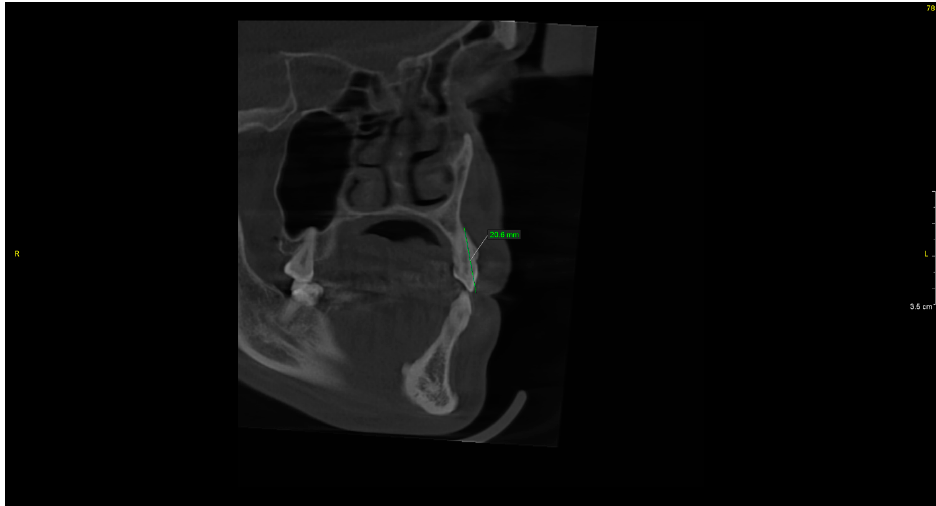
Figure 5. Patient 2. Vertical dimension of upper left canine (23)—Sagittal reconstruction from CBCT.